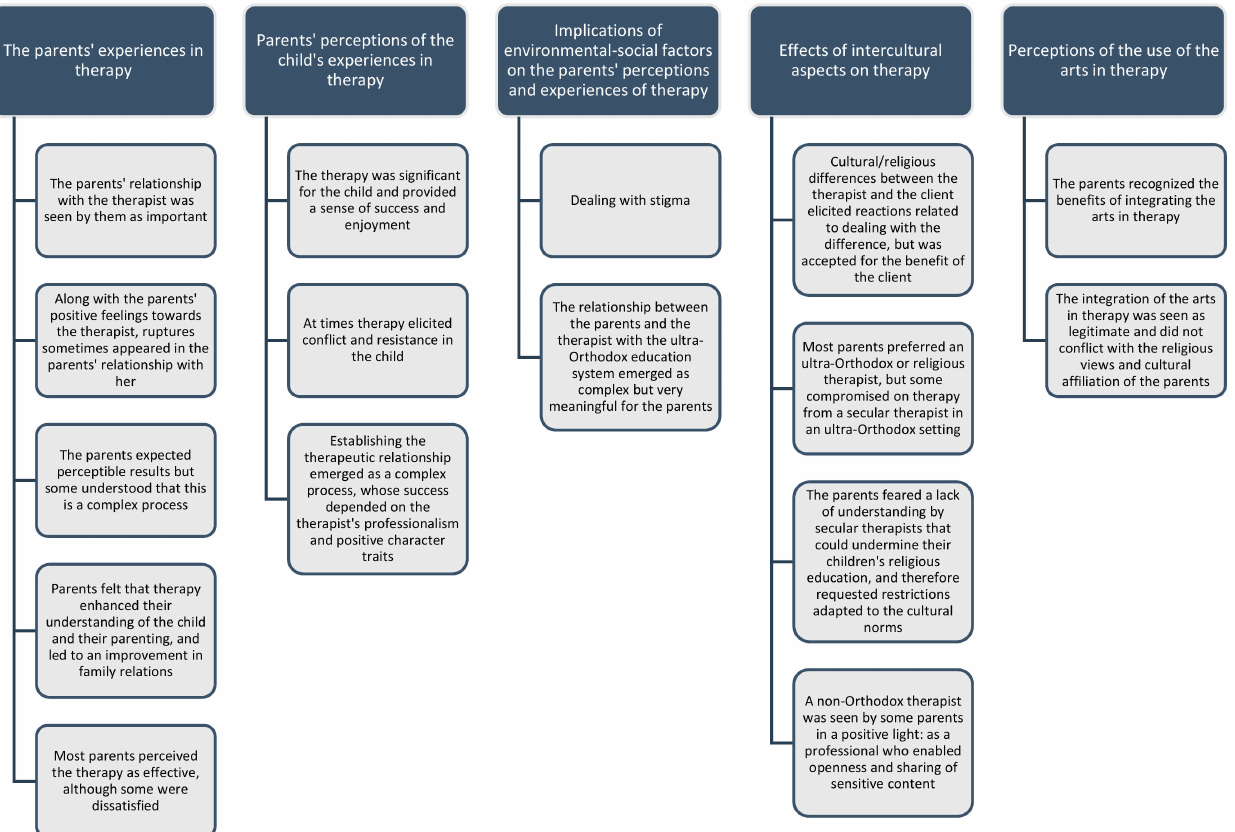
Figure 1. Central domains and core